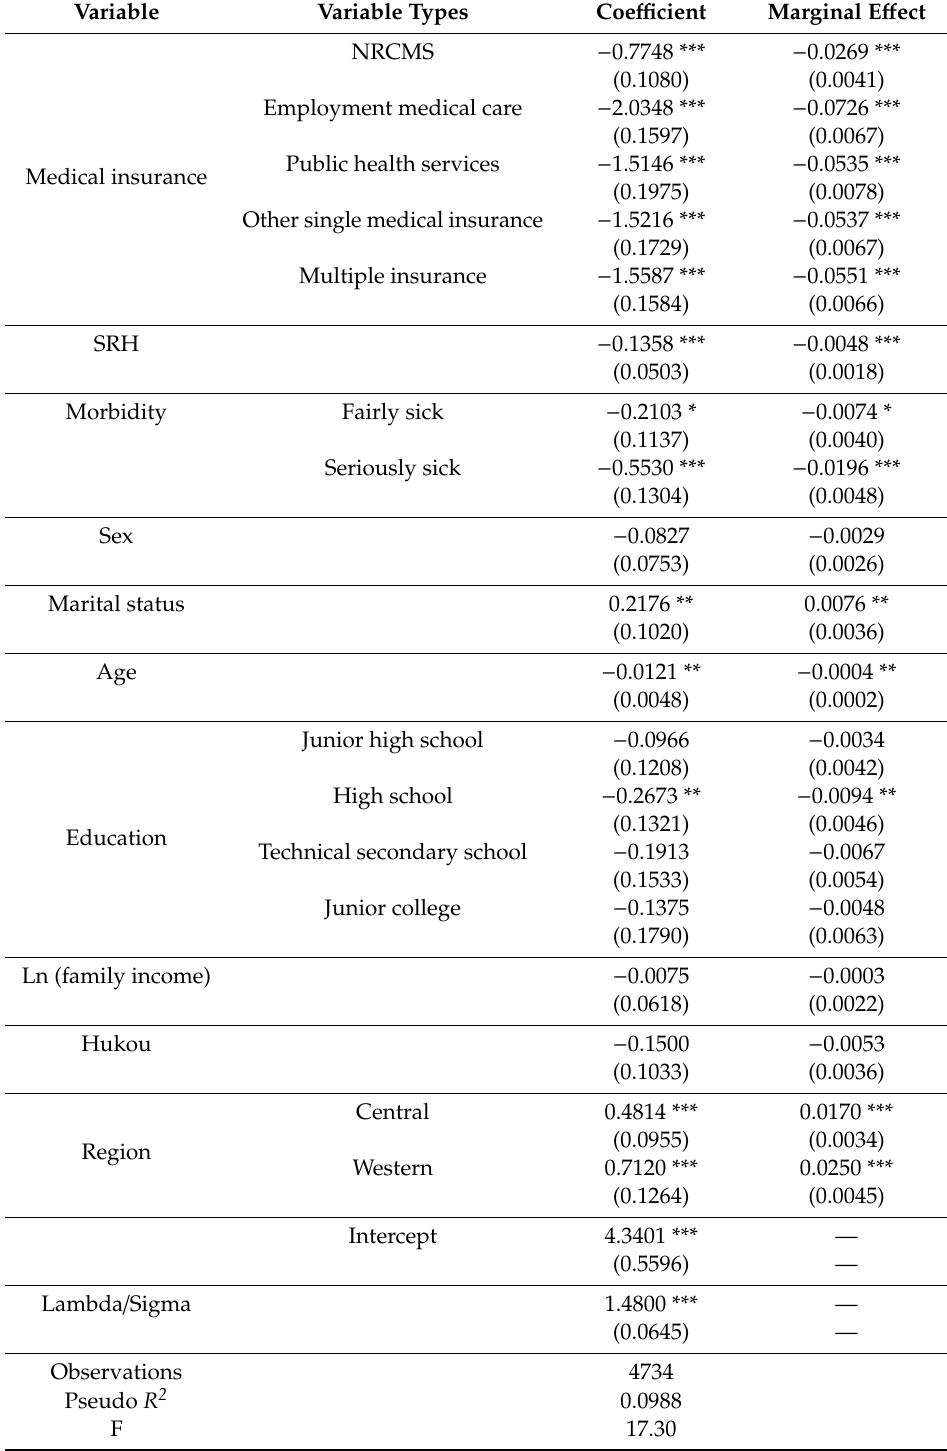
Table 4. Tobit regression results for migrant workers’ medical